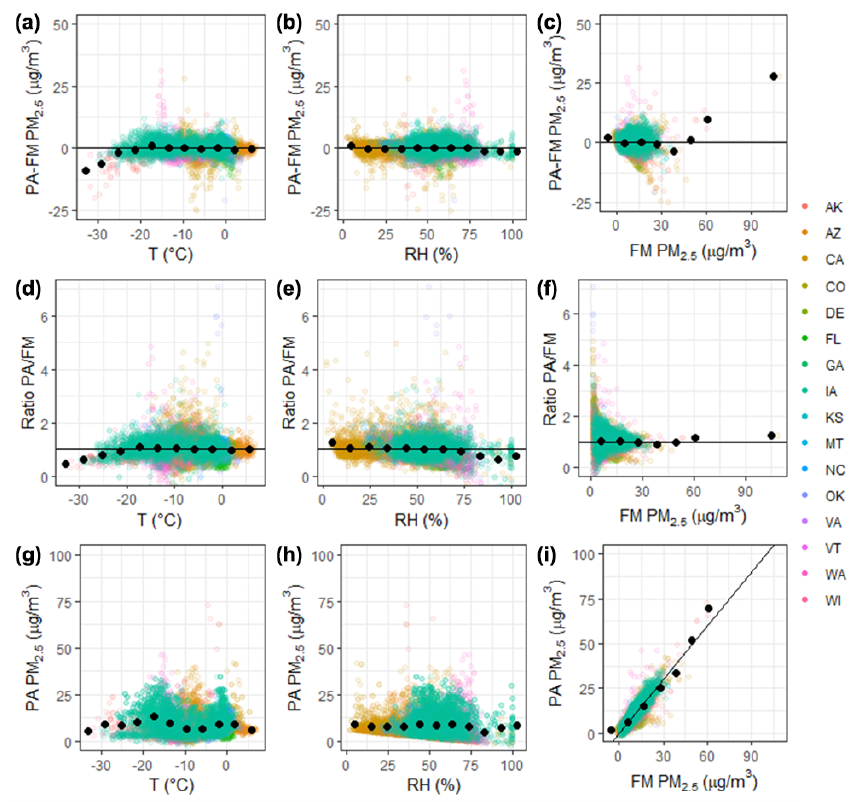
Figure 5. Error and ratio between corrected PurpleAir (PA) and FRM or FEM measurements are shown along with corrected PurpleAir PM 2 . 5 data (corrected using Eq. 10) as influenced by temperature, RH, and FRM or FEM PM 2 . 5 concentration. Colors indicate states, and black points indicate averages in 10